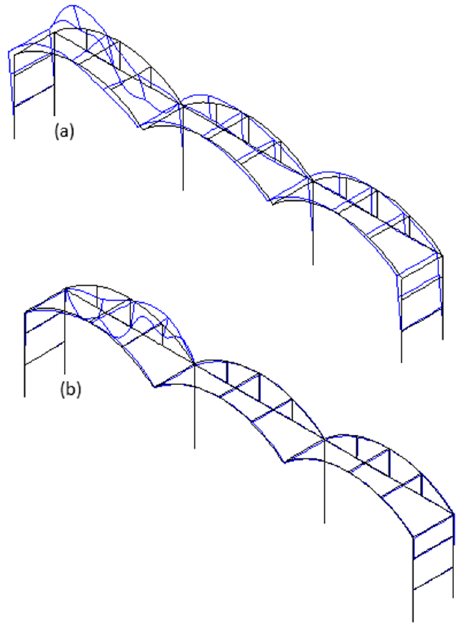
Figure 20. Buckling mode for ( a ) load combination 1 based on wind loads according to EN 13031-1 (2001) (first arch, up-down displacement type) and ( b ) load combination 1CFD based on wind loads calculated through CFD (first arch, down-up displacement type).